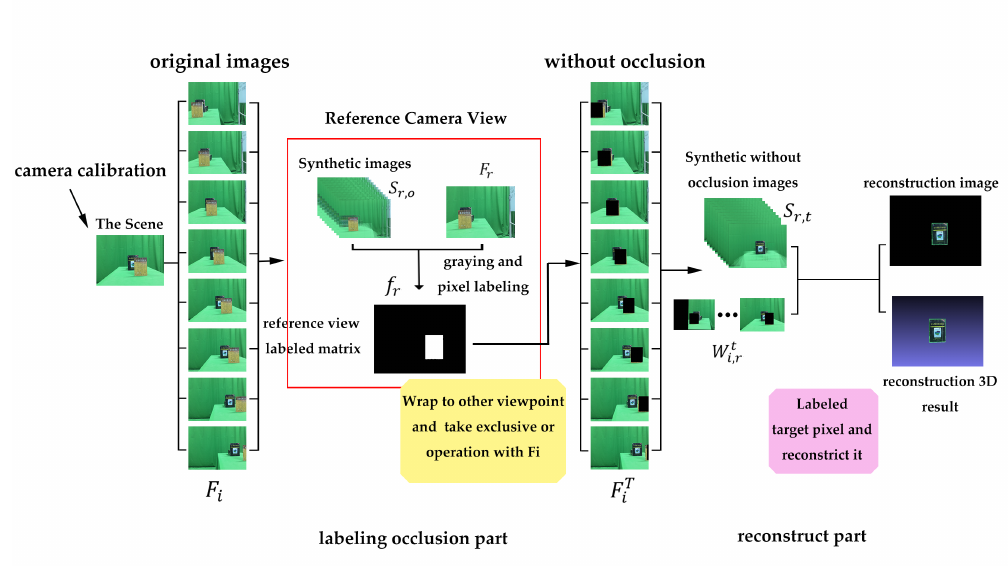
Figure 4. The processing pipeline of the proposed